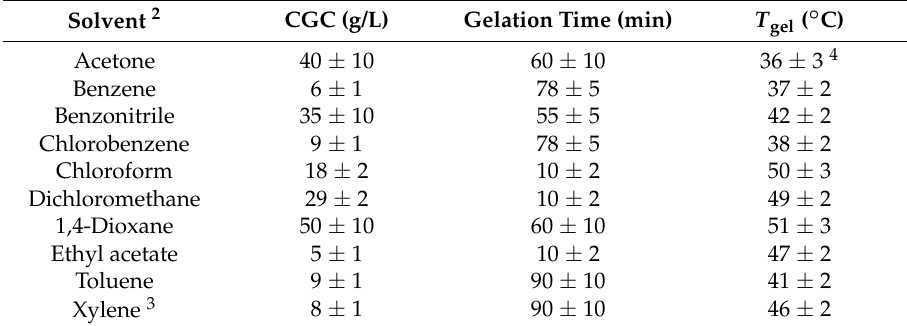
Table 1. Gelation ability of TTF–triglycyl derivative 14 , critical gelation concentration (CGC), gelation time, and gel -to- sol transition temperature ( T gel ).